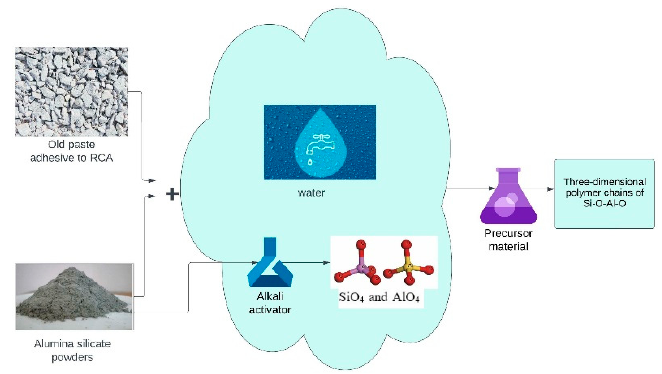
Figure 1. Reaction mechanism of the geopolymerisation of the RCA-based GC.